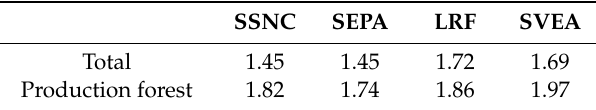
Table 3. Net present value (1000 EUR / ha, using a conversion rate of 1 EUR = 10 SEK) in the stakeholder scenarios. The interest rate was